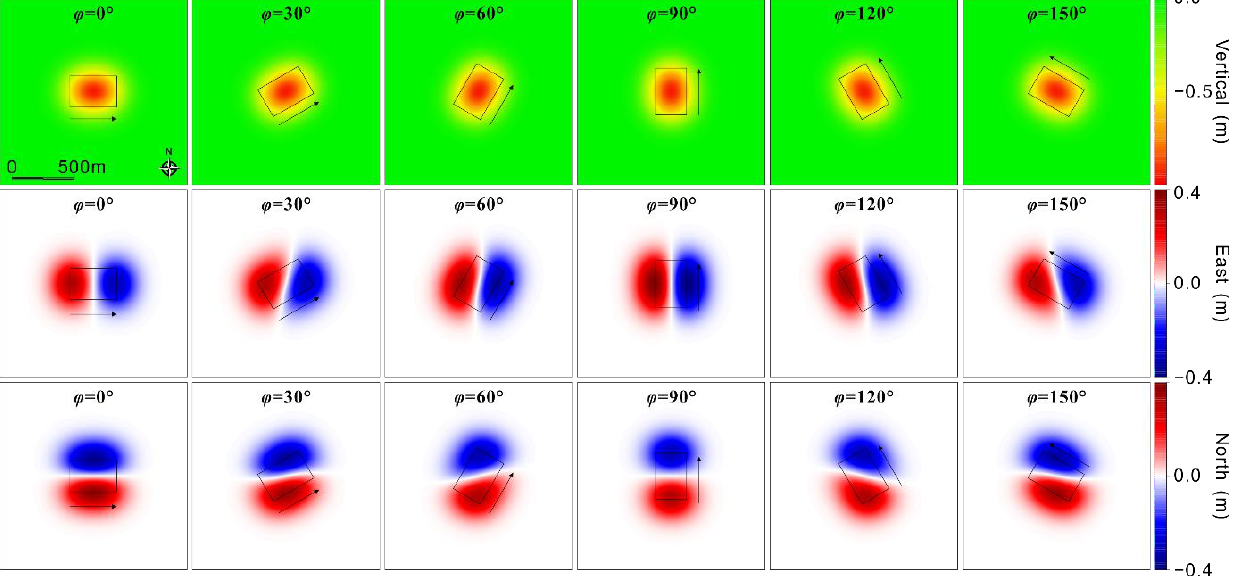
Figure 3. The PIM-simulated 3D displacements in the vertical (top row), east (middle row), and north (bottom row) directions caused by underground ground working panels whose advancing directions were given by ϕ = 0 ◦ ,30 ◦ ,60 ◦ ,90 ◦ ,120 ◦ ,150 ◦ . The negative values denote ground surface subsidence or horizontal movement along the west or south directions.